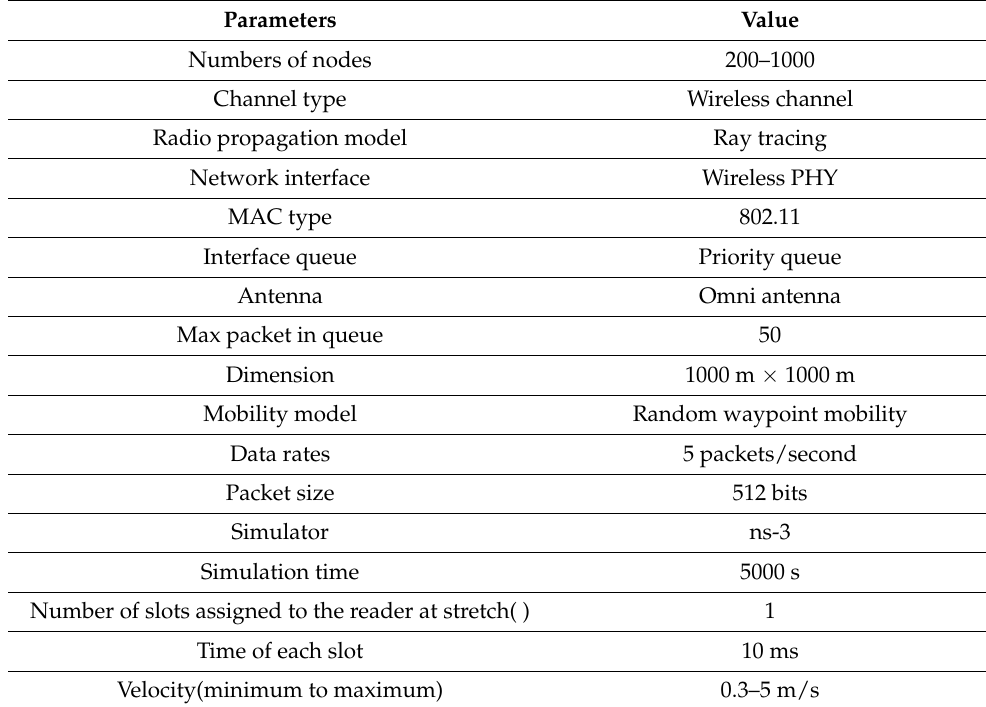
Table 1. Simulation